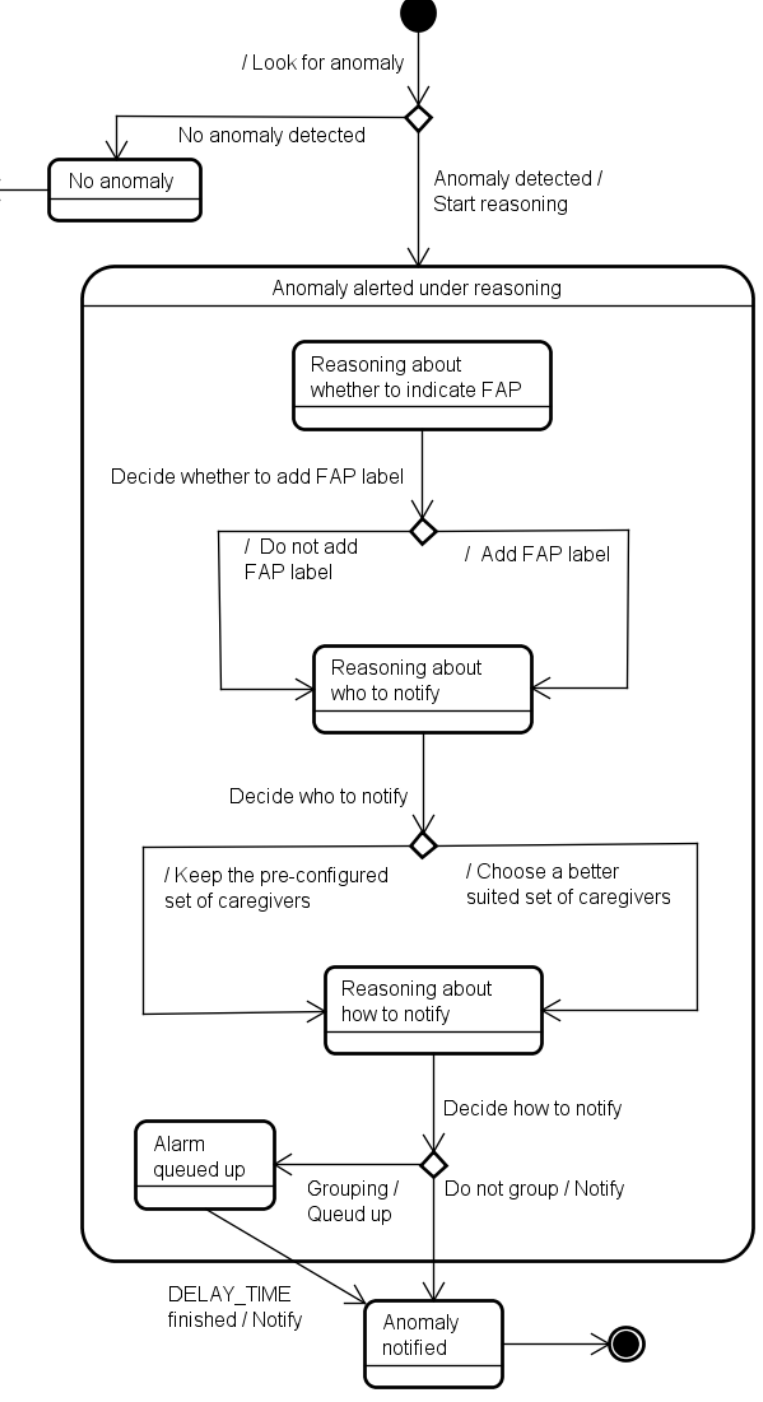
Figure 6. A high-level representation of the decision-making processes used during reasoning. FAP: false alarm